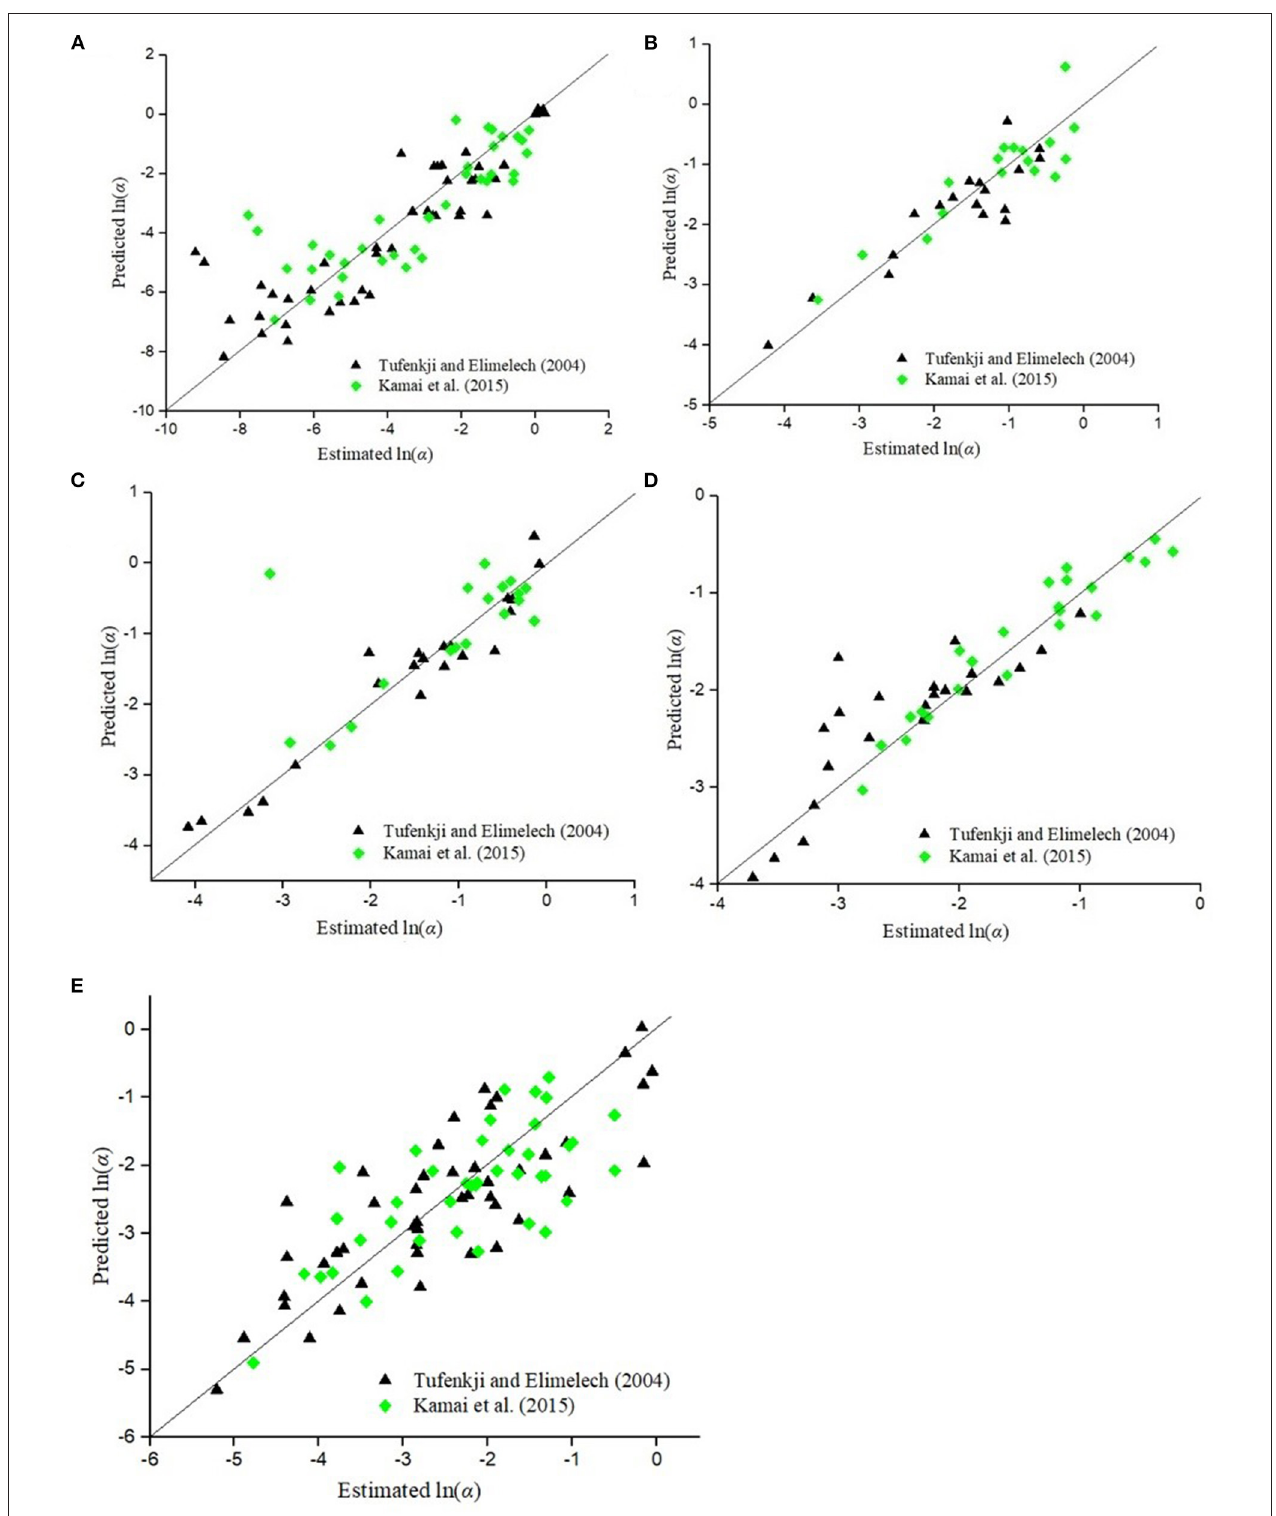
FIGURE 6 | Comparison of α values predicted by the empirical model Equation (13) developed in this study with the corresponding values calculated as the ratio of experimentally estimated Da a and Da a ( CFT ) for η 0 expressions proposed by Tufenkji and Elimelech (2004) and Kamai et al. (2015) for (A) viruses, (B) bacteria, (C) GO NPs, (D) TiO 2 NPs, and (E) CML colloids.